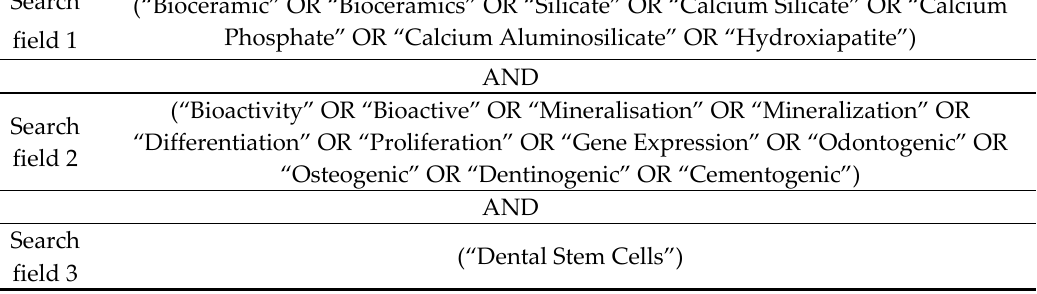
Figure 1. Search Strategy Illustration. Figure 1. Search strategy